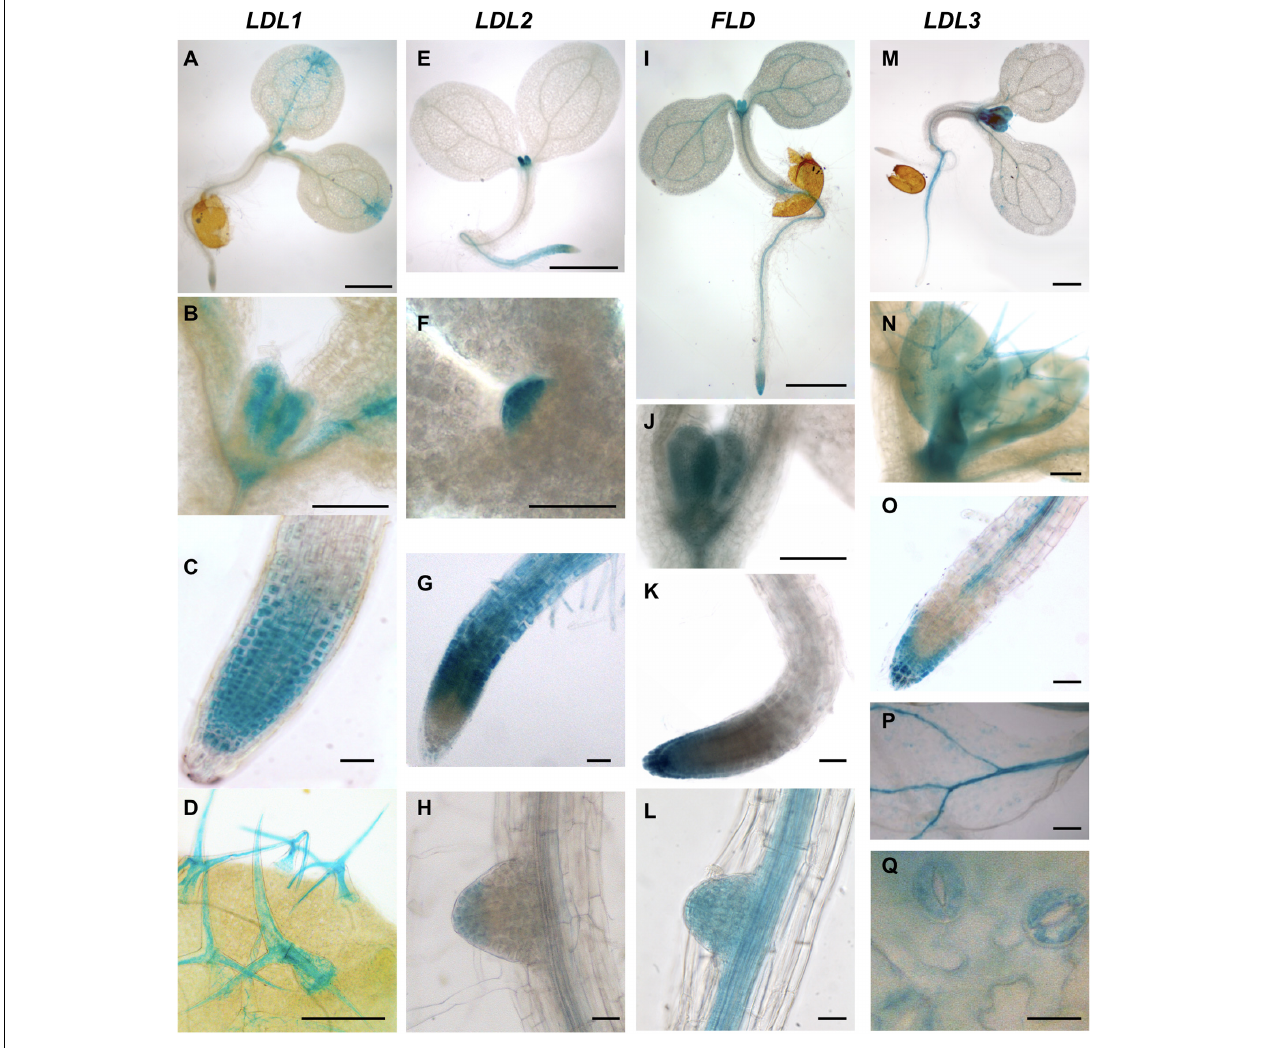
FIGURE 4 | Promoter activity of Arabidopsis LDL / FLD genes during vegetative development. Histochemical GUS staining of LDL/FLD::GFP-GUS Arabidopsis seedlings is shown. Bars indicate 1 mm in (A,E,I,M) , 200 µ m in (N) , 100 µ m in (B–D,F–H,J–L,O,P) , and 20 µ m in (Q)